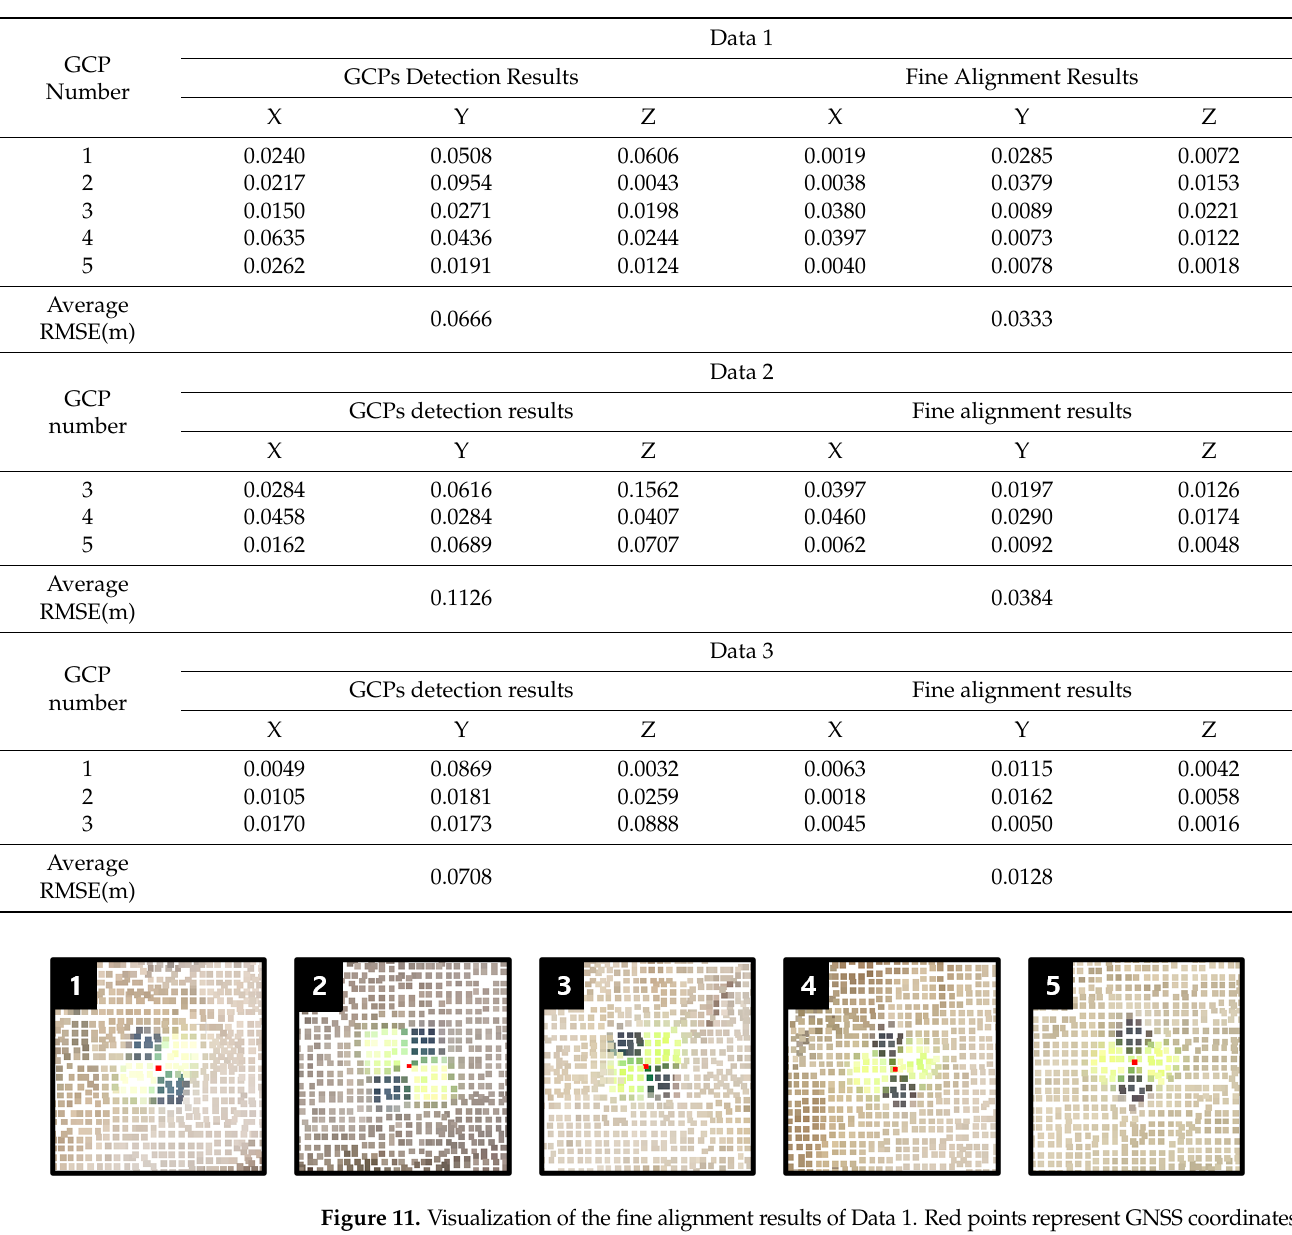
Table 3. Quantitative results on the fine alignment performance of the developed framework. Each value means the difference from the GNSS coordinates.